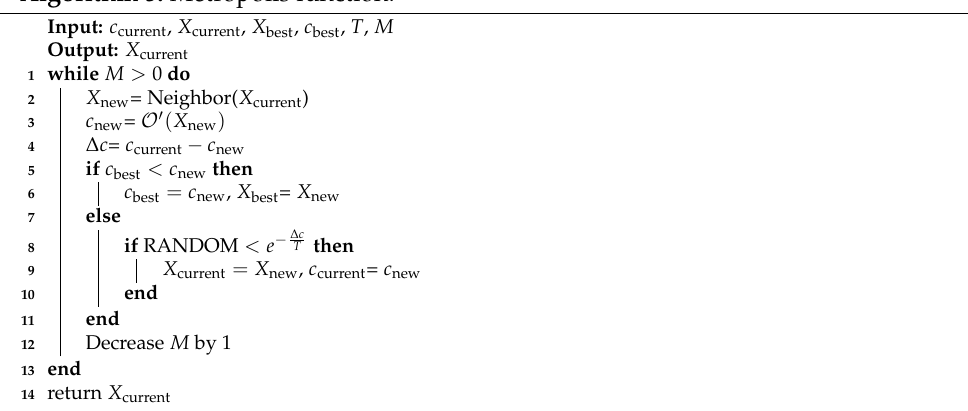
Algorithm 5: Metropolis